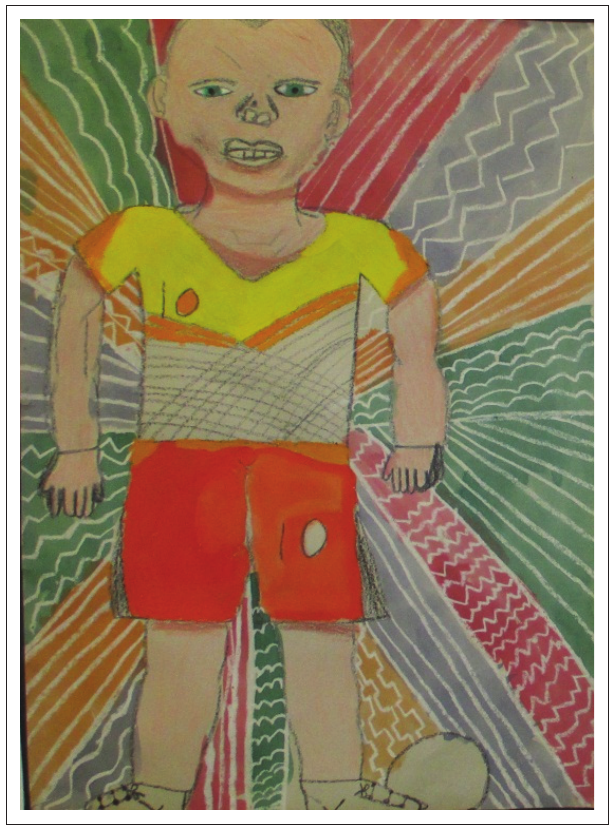
FIGURE 3: Myself playing